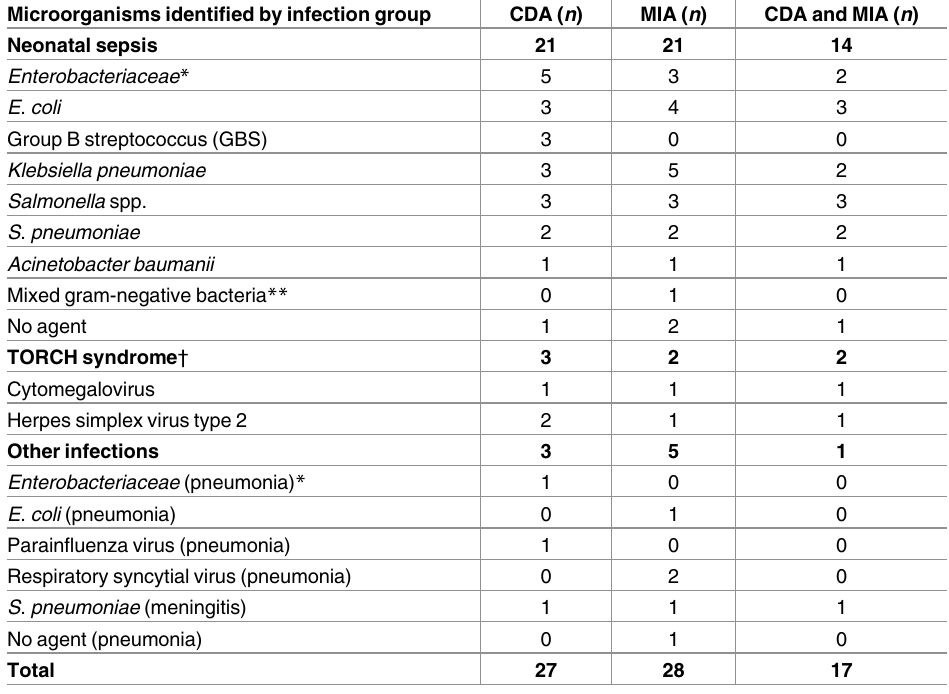
* Mixed infection of at least 2 of these enterobacteria: Enterobacter cloacae , E . coli , or K . pneumoniae . ** Gram-negative bacteria included the following: A . baumanii + K . pneumoniae + E . coli . † TORCH syndrome includes infections by T . gondii , T . pallidum , parvovirus B19, lymphocytic choriomeningitis virus, herpes virus, cytomegalovirus, and rubella virus.